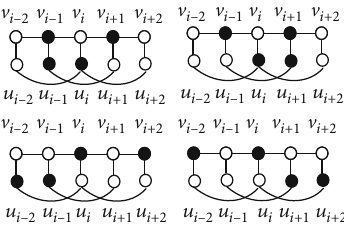
Figure 6: Eternally dominating B